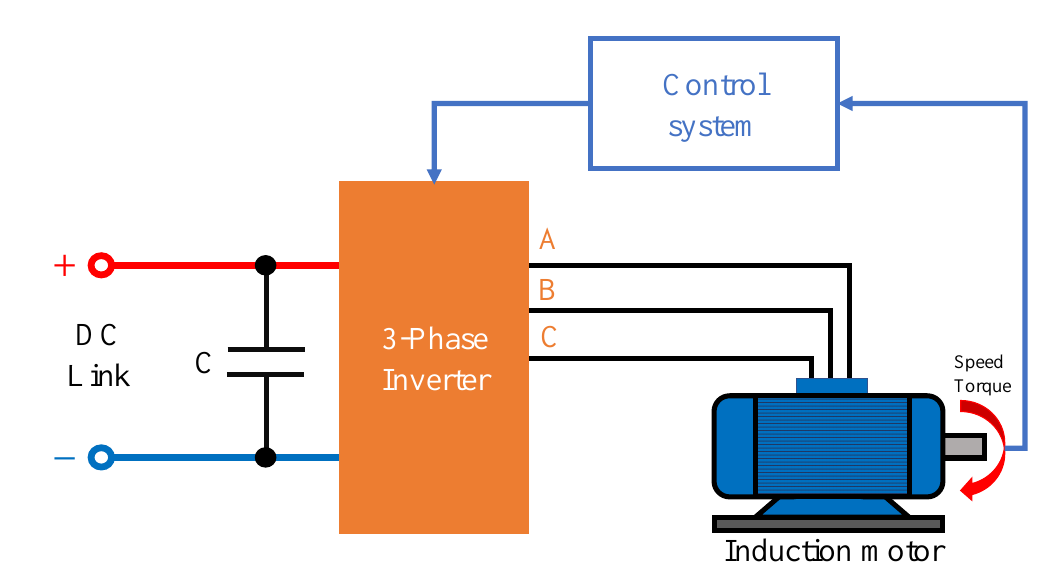
Figure 1. Graphical representation of the drive system. As seen from Figure 1, the induction motor (LUST ASH-22-20K13-000) is fed by a three-phase two-lever IGBT inverter (SEMIKRON Semiteach IGBT), the schematic view of which is shown in Figure 2.